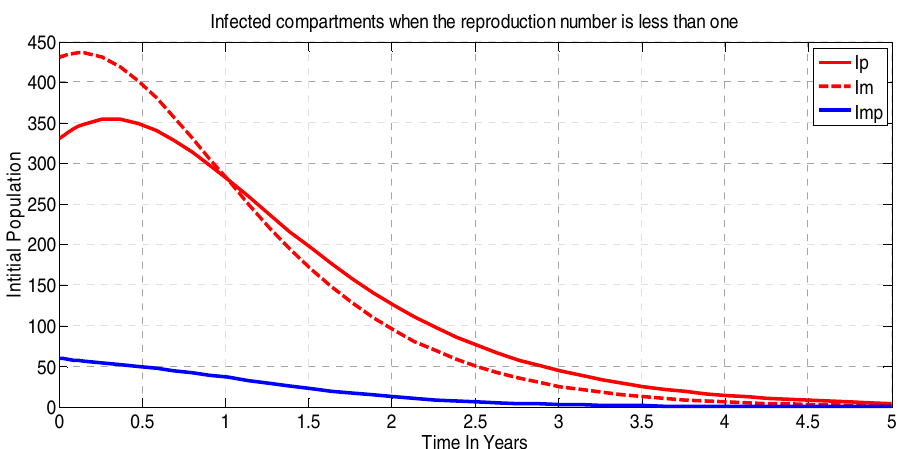
Figure 3. Infectious class when reproduction number is less than